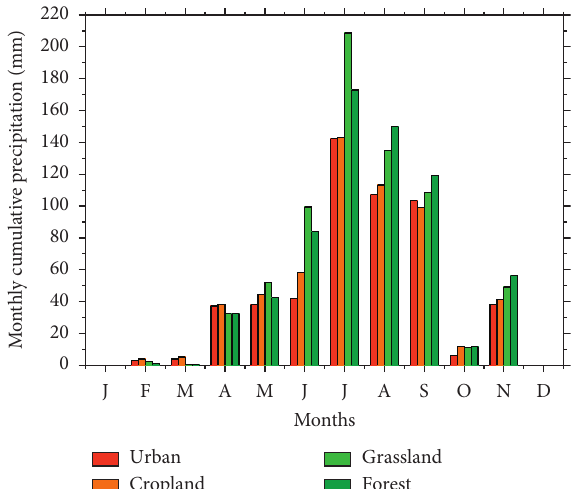
Figure 8: Spatial average of the monthly cumulative precipitation for the four main LUCs.